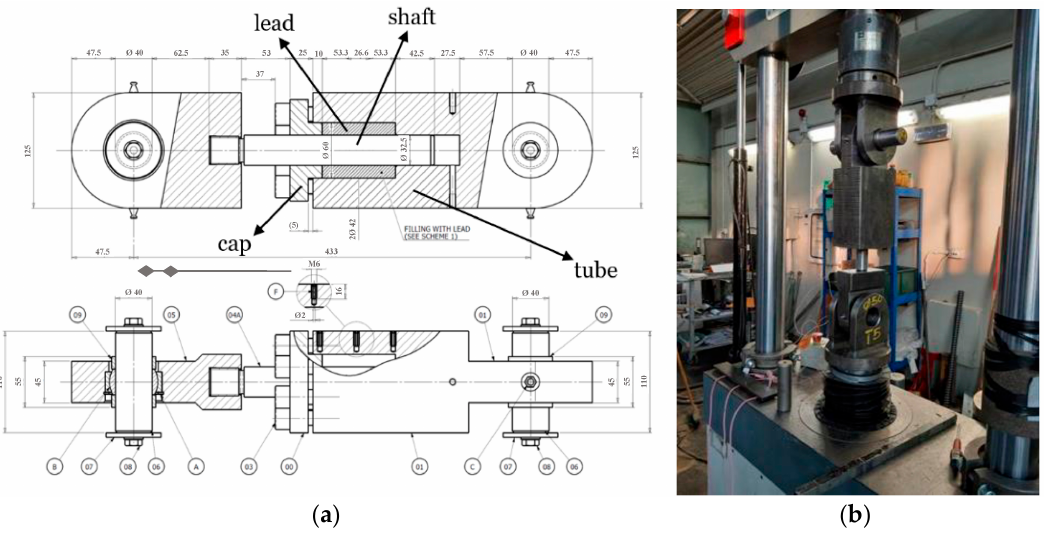
Figure 12. PS-LED damper proposed by Quaglini et al. able to reduce the costs of production: ( a ) description of the damper, ( b ) experimental set-up [160].